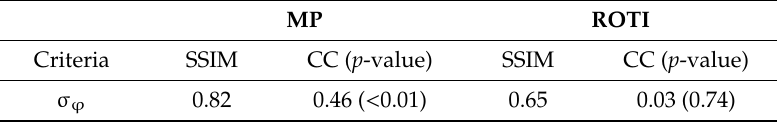
Table 15. SSIM and CC between the maps shown in Figure